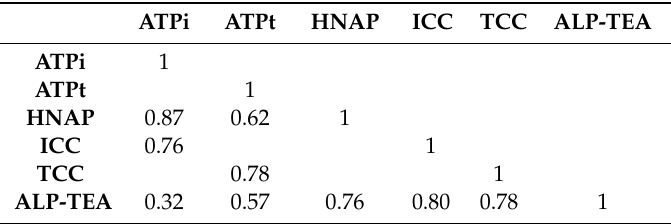
Table 2. Correlation coe ffi cients of FCM, ALP-TEA and ATP